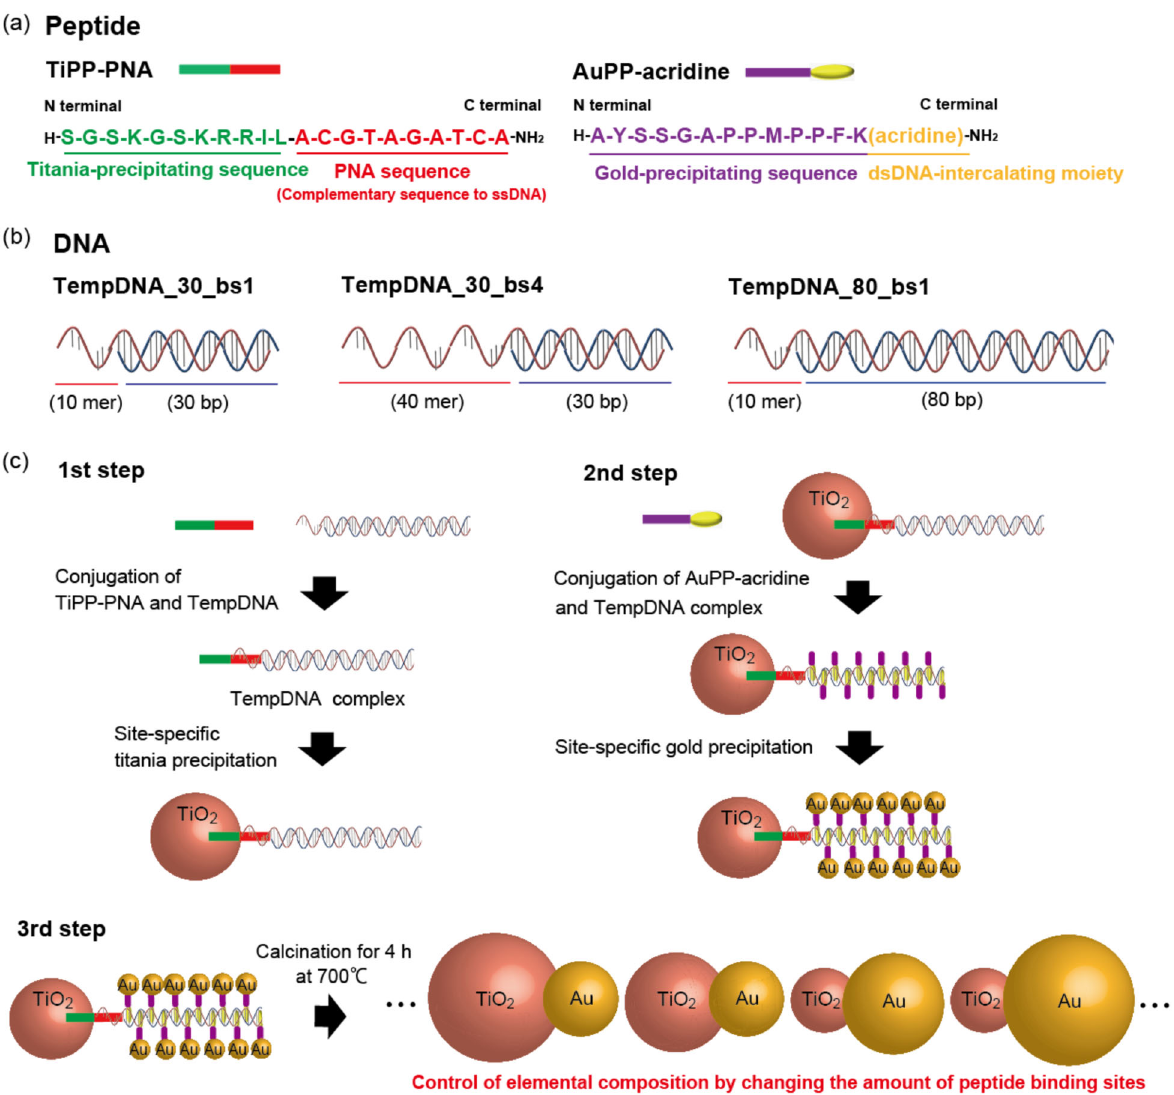
Fig. 1 Design of peptides and DNAs. a Sequences of the titania-precipitating peptide (TiPP-PNA) and gold-precipitating peptide (AuPP-acridine) used in this study. b Illustration of the three DNA sequences (TempDNA_30_bs1, TempDNA_30_bs4, and TempDNA_80_bs1) used in this study (the other three DNA sequences are shown in Supplementary Fig. 2). c Outline of the site-speci fi c titania and gold precipitation using the DNA and the two peptides (TiPP- PNA Table 1 Properties of manufactured gold-titania nanocomposites by site-speci fi c mineralization using various TempDNAs. Properties